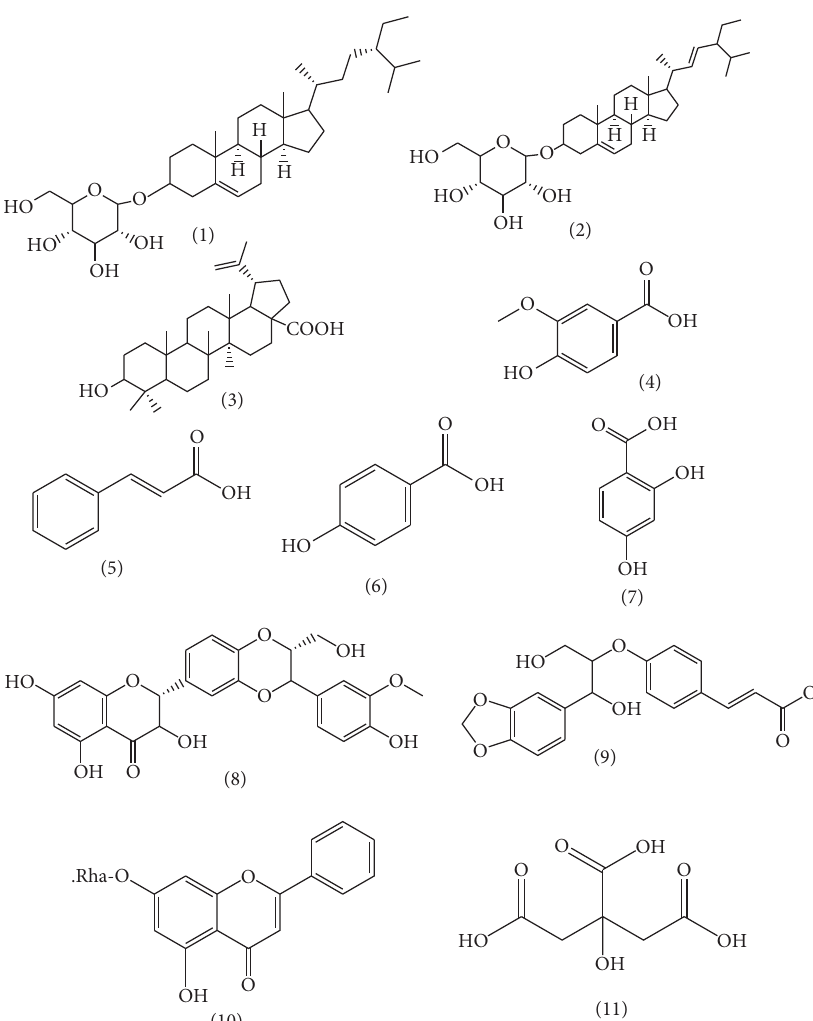
Figure 1: Structures of compounds isolated from the whole aerial fowering parts of C. occidentalis